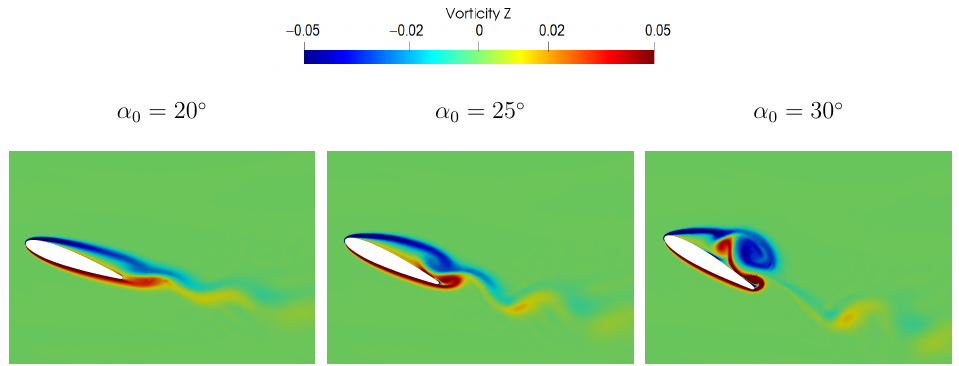
Figure 6. Instantaneous vorticity fields ω z around the oscillating hydrofoil 2, α 0 = 20, 25 and 30 ◦ , f ∗ = 0.025, ∆ h = 0.8 m, and t ∗ =